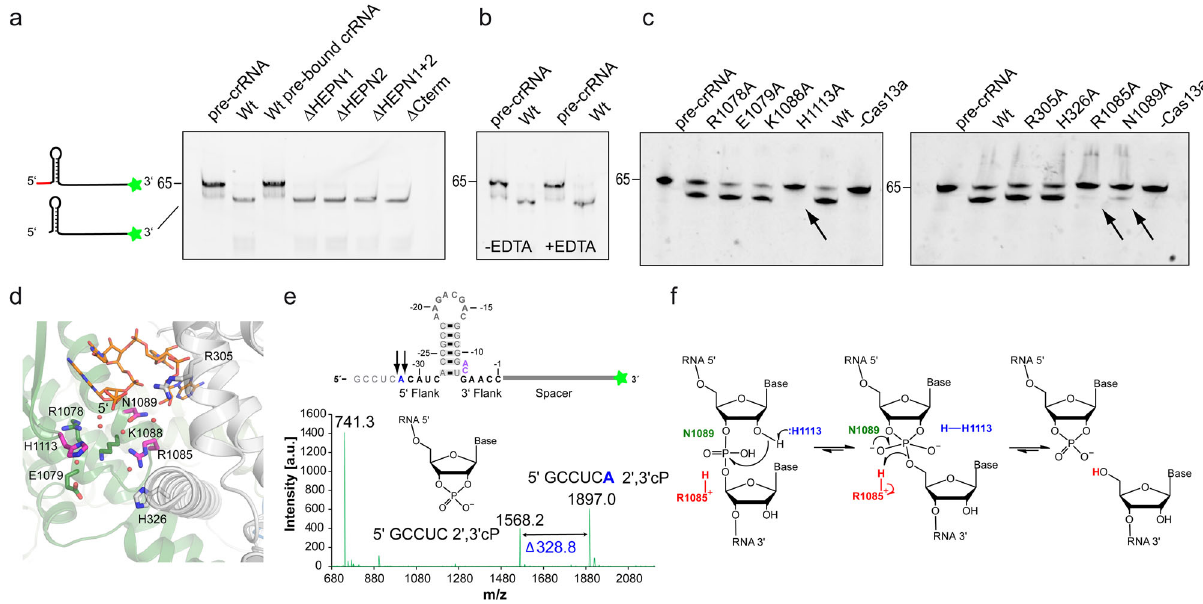
Fig. 3 Processing of pre-crRNA by RcCas13a. a RcCas13a cleaves 3 ′ -FAM-labeled pre-crRNA (65 mer) independent of its catalytic HEPN-domains or the C-terminal domain. RcCas13a pre-bound to crRNA does not process 3 ′ -FAM-labeled pre-crRNA. Δ CTD = Δ C-terminal domain; H1* = RcCas13a R464A/H469A ; H2* = RcCas13a R464A/H469A ; H1 + 2* = RcCas13a R464A/H469A/R1052A/H1057A . b Pre-crRNA cleavage is not inhibited by EDTA and hence metal-ion-independent. c Identi fi cation of residues involved in pre-crRNA processing by mutational analysis. d Close-up view of the 5 ′ end of the crRNA in the RcCas13a binary structure. Residues in the vicinity of the 5 ′ end of the crRNA and subject to mutational analysis are shown as stick model, with the three residues crucial for pre-crRNA processing highlighted in pink. Water molecules are shown as spheres. e MALDI-TOF analysis of the pre-crRNA processing reaction shows cleavage of the pre- crRNA 4 or 5 nt 5 ′ of the stem-loop, resulting in a 2 ′ ,3 ′ -cyclic 3 ′ phosphate (2 ′ ,3 ′ -cP). f Proposed mechanism of pre-crRNA processing by acid-base catalysis. His 1113 acts as the base, abstracting the proton of the 2 ′ OH next to the scissile phosphate. Arg 1085 acts as a general acid and protonates the 5 ′ -oxygen leaving